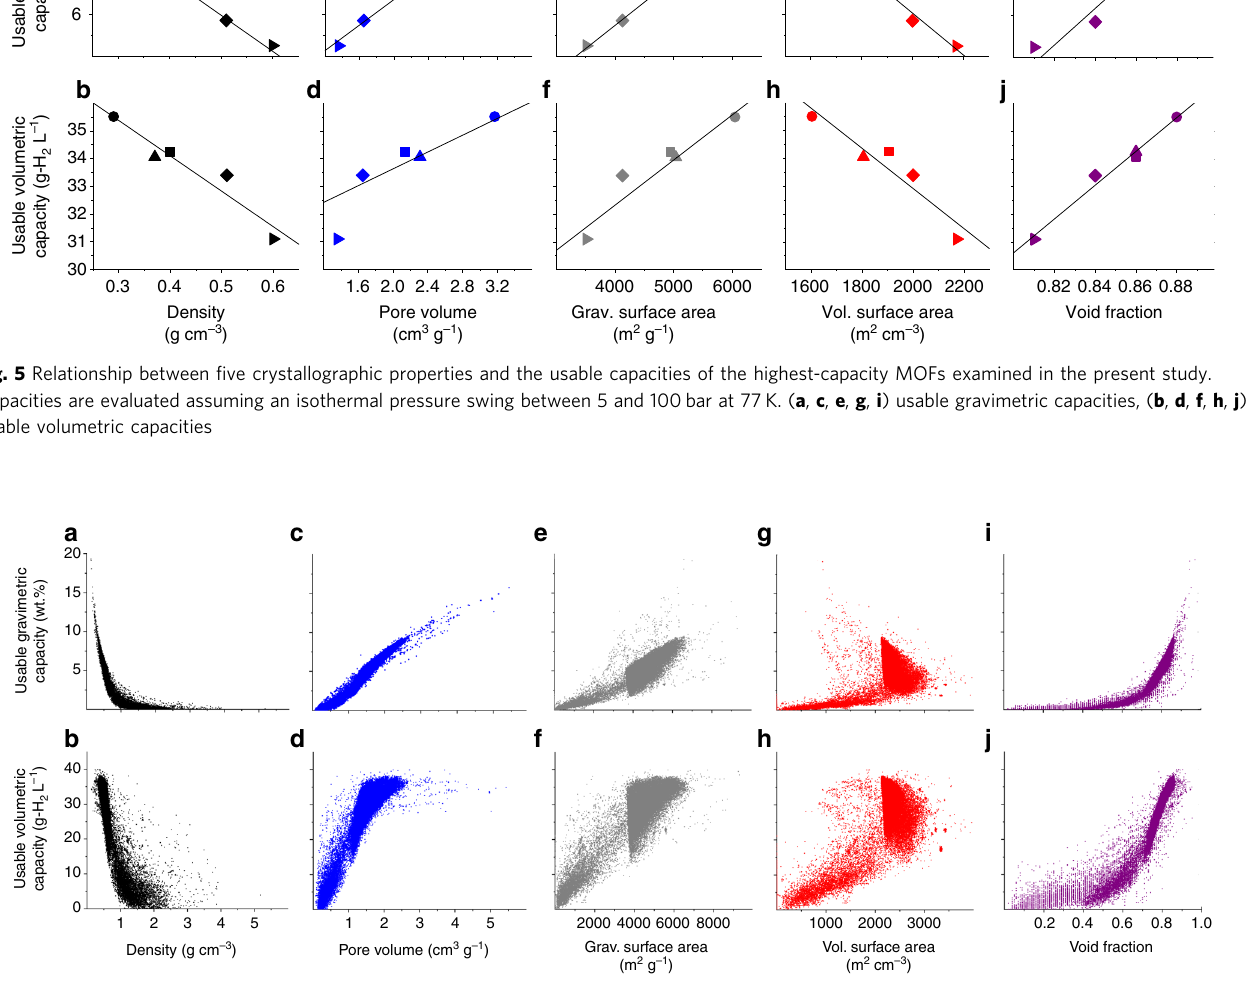
Fig. 6 Usable capacities of 43,777 MOFs as a function of fi ve crystallographic properties, assuming pressure-swing operation between 100 and 5 bar at 77 K. ( a , c , e , g , i ) gravimetric capacities, ( b , d , f , h , j ) volumetric minimizing the amount of H 2 retained in the MOF in the low- pressure empty state 4 .